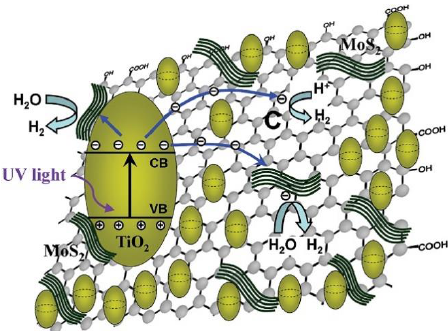
Figure 20. Schematic illustration of the charge transfer in TiO 2 /MoS 2 /graphene composites. Reprinted with permission from [135]. Copyright 2012, American Chemical Society.